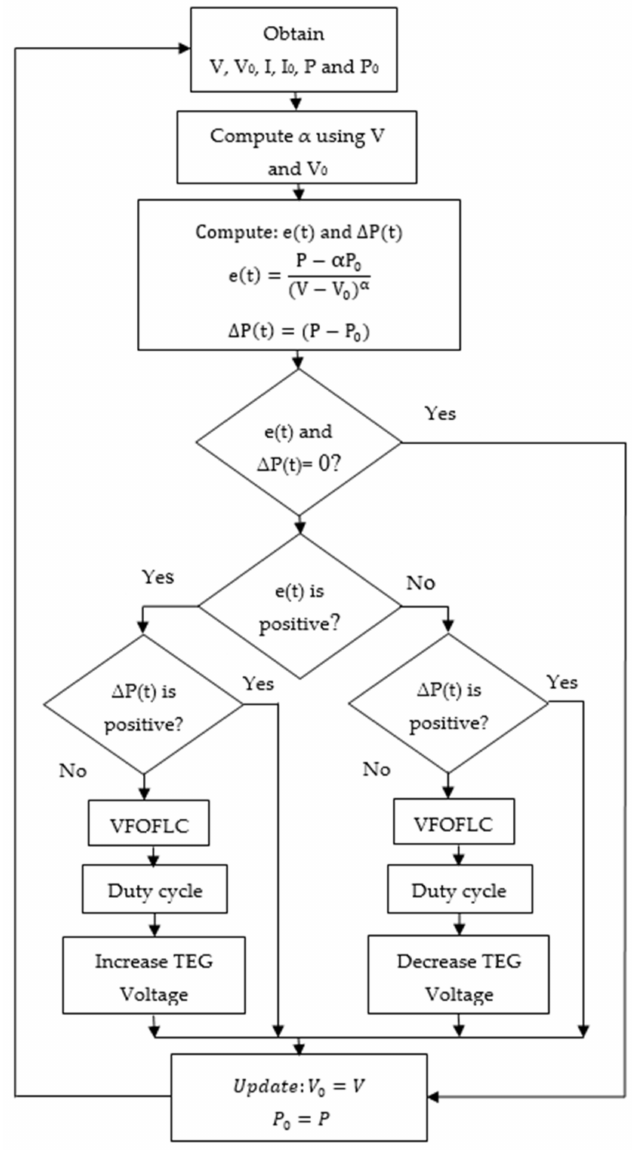
Figure 8. Control logic flow chart of the VFOFLC-based MPPT technique.